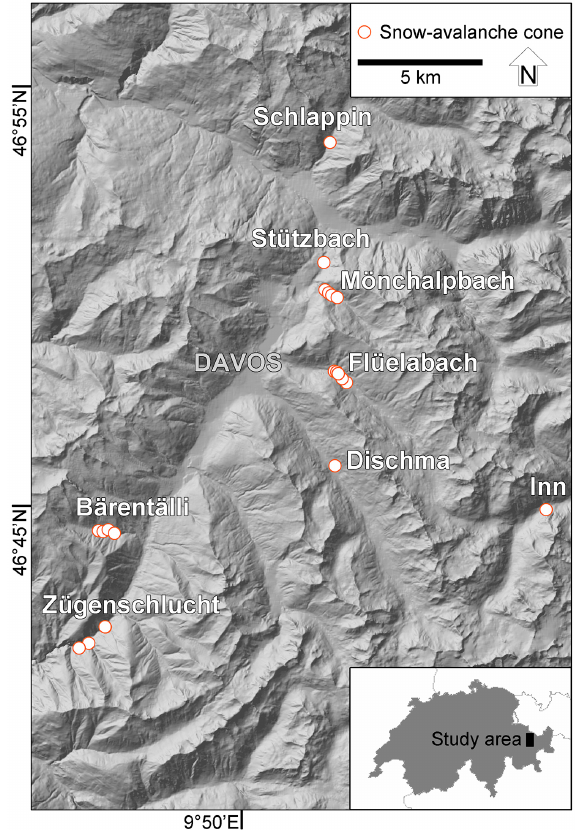
Fig. 2. Map of study area and locations of the n = 28 sampled wet snow-avalanche deposits in the eastern Swiss Alps, canton of